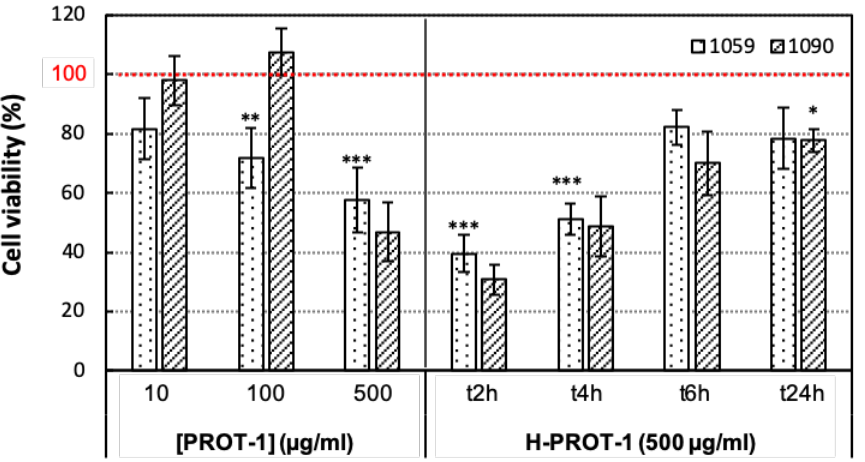
Figure 5. Effect of PROT-1 and H-PROT-1 on fibroblast proliferation in vitro (MTT assay). Results are expressed as the mean relative percentage of viable fibroblasts compared to the negative control (100%). Significant differences between values obtained with samples and negative control ( n = 20) are indicated by * ( p < 0.05), ** ( p < 0.01) and *** ( p < 0.001).